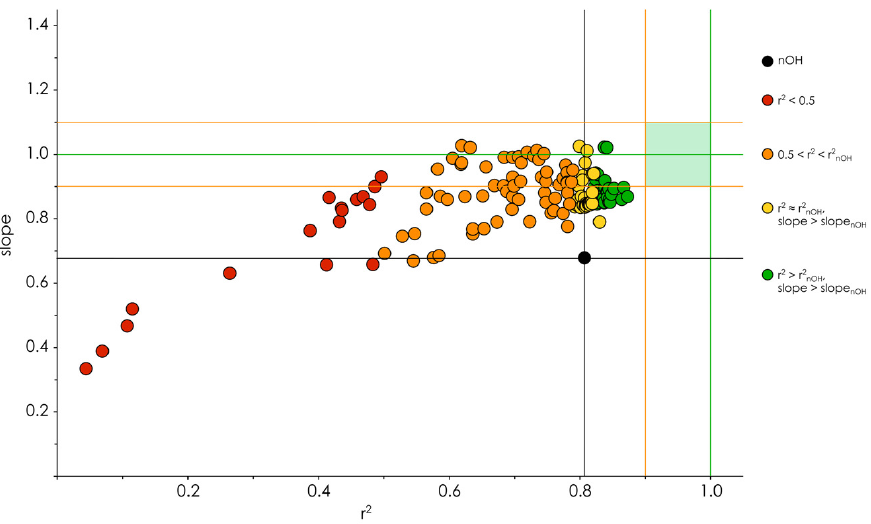
Figure 6. Plot of linear regression models’ slopes vs. squared correlation coefficients r 2 colored by their accuracy grouping. Black lines correspond to the r 2 and slope of the “unclassified” nOH model (0.807 and 0.677, respectively). Green lines denote r 2 = 1 and slope = 1, orange lines—r 2 = 0.9 and slope = 0.9 and 1.1. Pale green rectangle outlines the desirable zone for the models’ parameters. The plotted models were built using DPPH • assay